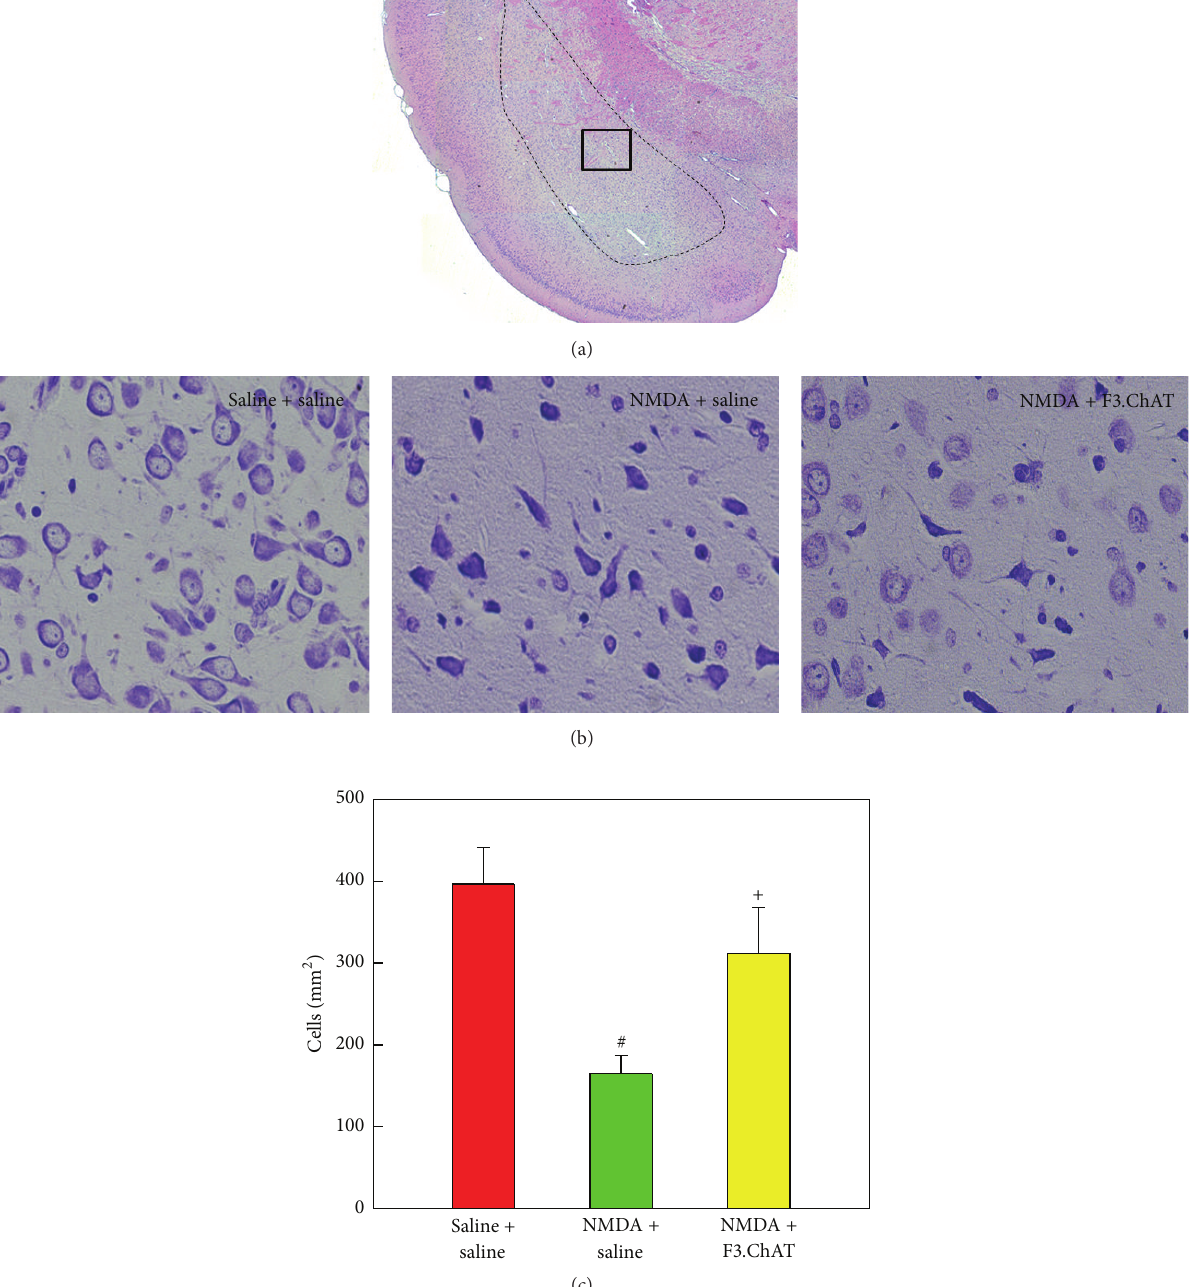
Figure 5: Representative hematoxylin-eosin (a) and Nissl staining (b) images of the amygdala, and the cell number in the amygdala (c) 4 weeks after transplantation. After examination on the entire amygdala (dotted line in (a)), magnified medial amygdala (inset in (a)) was photographed (b), and the number of survived neurons was counted (c). NMDA, N-methyl-d-aspartate. # Significantly different from vehicle control ( 𝑃 < 0.05 ). + Significantly different from NMDA alone ( 𝑃 < 0.05